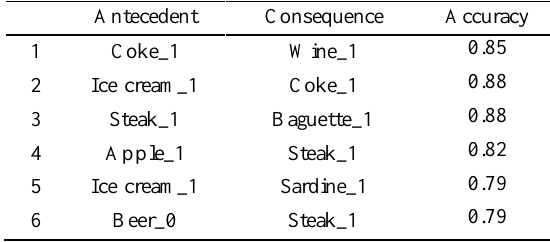
Table 2. Study association rule set K and its accuracy evaluation